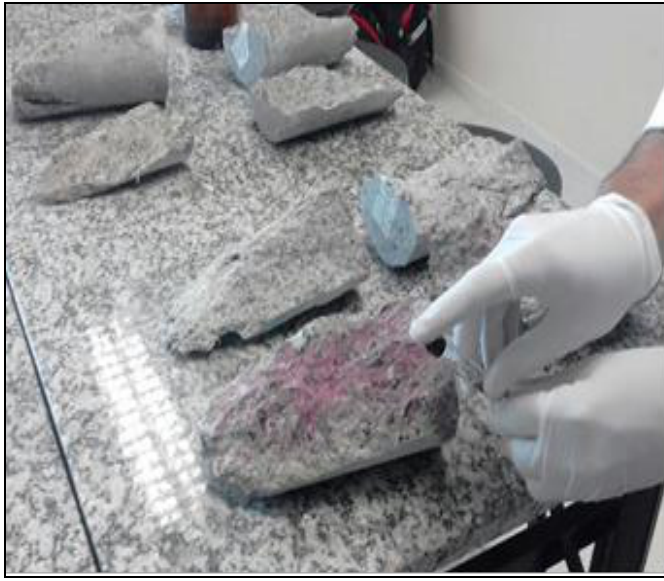
Figura 8: Início da aplicação do indicador químico de fenolftaleína nos corpos de prova. Fonte: Autores,